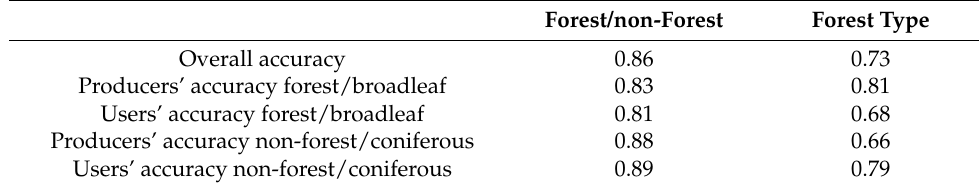
Table 2. Accuracy of the Sentinel-1 forest/non-forest and forest type map when compared to the Copernicus High Resolution Layers forest type dataset. The accuracies are summarized for the whole of Europe.